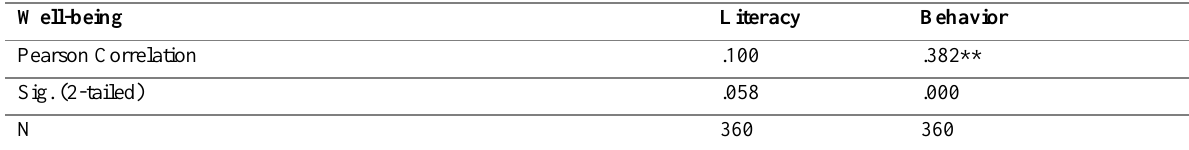
Table 6: Correlations between Financial Well-being and Financial Literacy and Financial